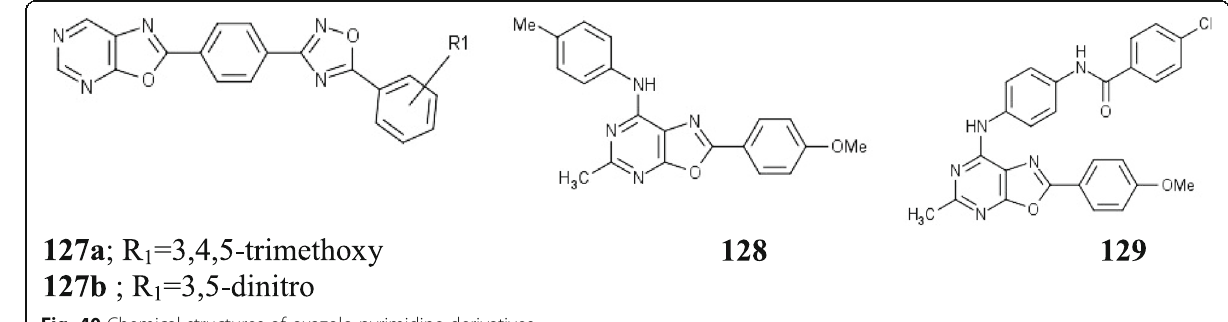
Fig. 40 Chemical structures of oxazolo pyrimidine derivatives